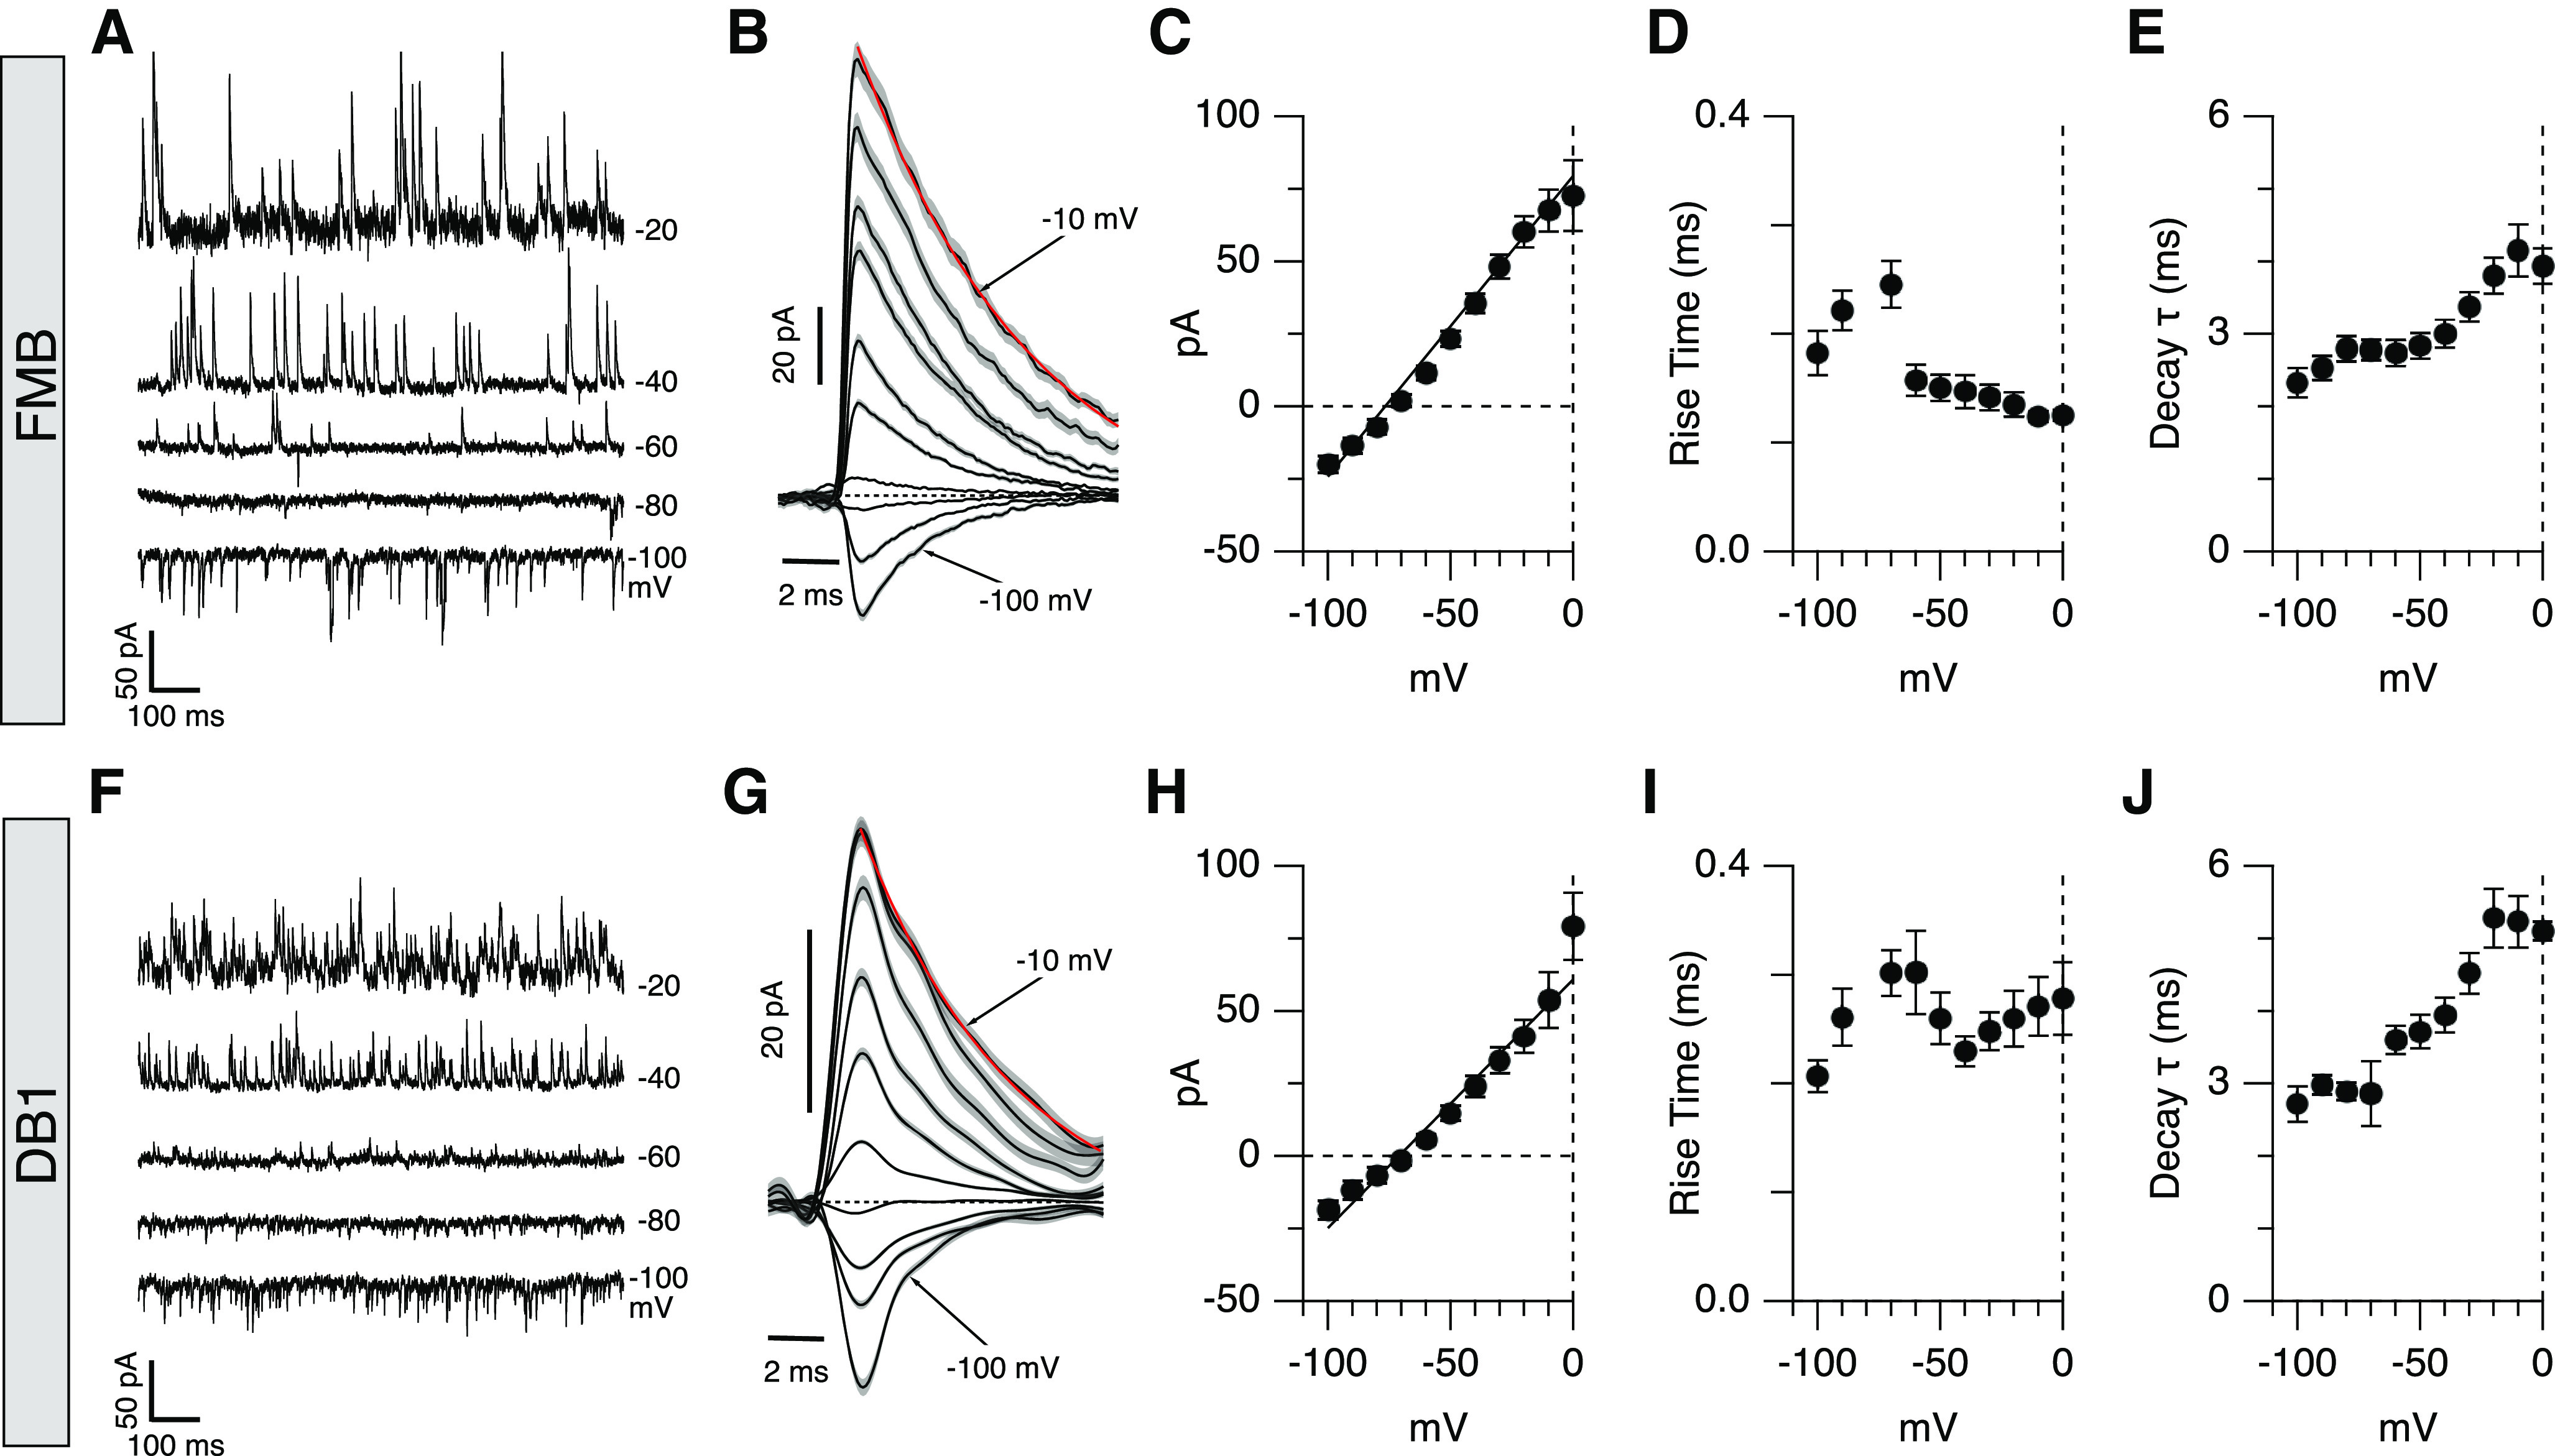
Properties of sIPSCs in FMB and DB1 bipolar cells. Quantification of sIPSC events in FMB (A–E) and DB1 (F–J) bipolar cells. A, F, Example traces showing sIPSCs in an FMB (A) and DB1 (F) cell at the holding potentials indicated to the right of traces. B, G, Average sIPSC events extracted from the same bipolar cells shown in A, F using a matched template filter (average of 64–126 events per voltage for FMB, average of 70–130 events per voltage for DB1 cells). Gray shading shows SEM. Red traces show single exponential fits to event decay at −10 mV. C, H, I-V plots showing sIPSC amplitude as a function of voltage for a group of FMB (n = 20 cells; C) and DB1 cells (n = 7 cells; H). Note that events reverse close to the inhibitory reversal potential. D, I, Average sIPSC rise-time for the group of FMB (D) and DB1 (I) cells. E, J, Average sIPSC decay time constants for FMB (E) and DB1 (J) cells. All graphs show mean ± SEM.